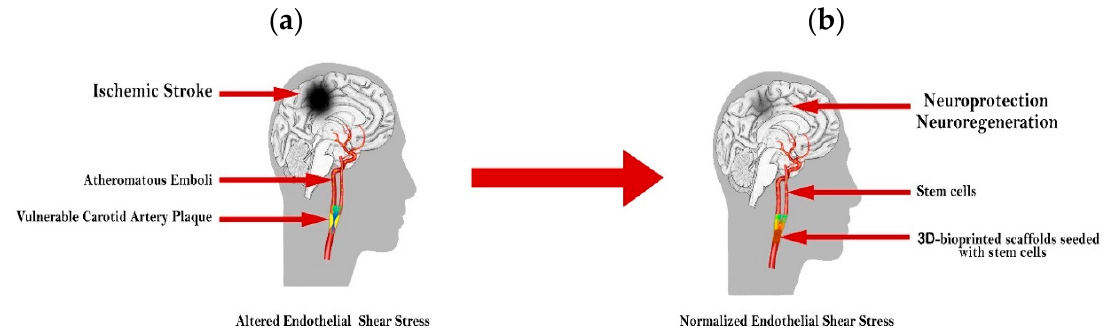
Figure 1. Stem cell therapy in ischemic stroke: ( a ) Vulnerable carotid artery plaque with altered endothelial shear stress (ESS) resulting in ischemic stroke; ( b ) 3D scaffold providing plaque stabilization, the correction of carotid stenosis and ESS with simultaneous neuroprotection and neuroregeneration at the level of the ischemic brain.